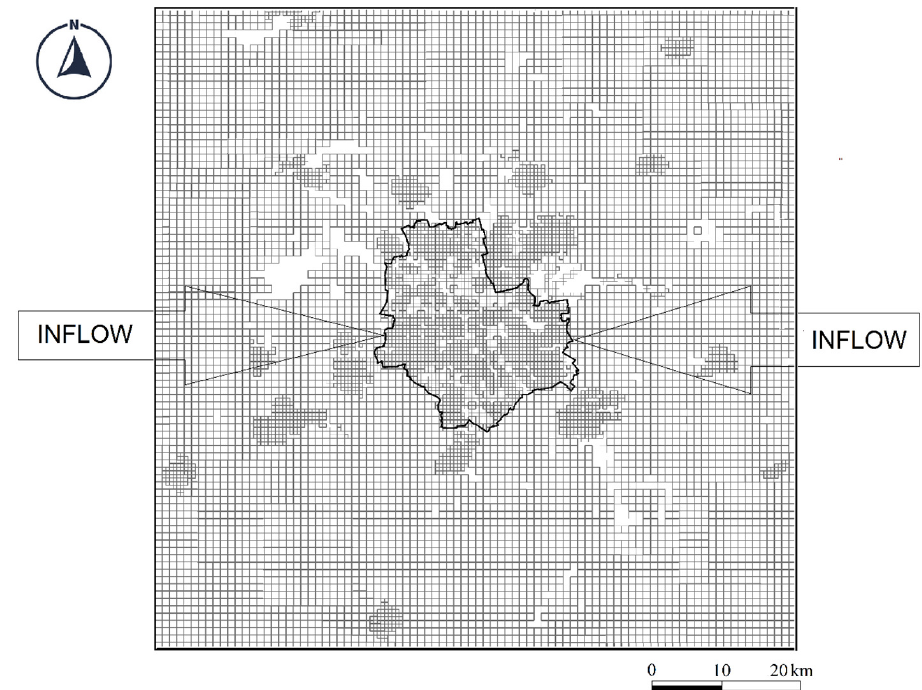
Figure 1. The study domain covering receptor area, inside Warsaw and in its vicinity.